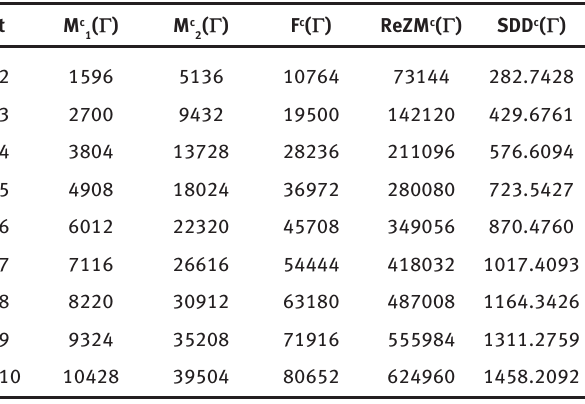
Table 10: Comparison among different Zagreb connection indices of MOF (t). 1